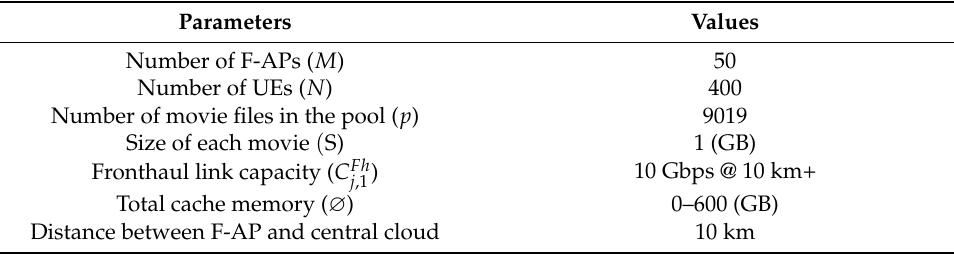
Table 8. Fog radio access network (F-RAN) system parameters.